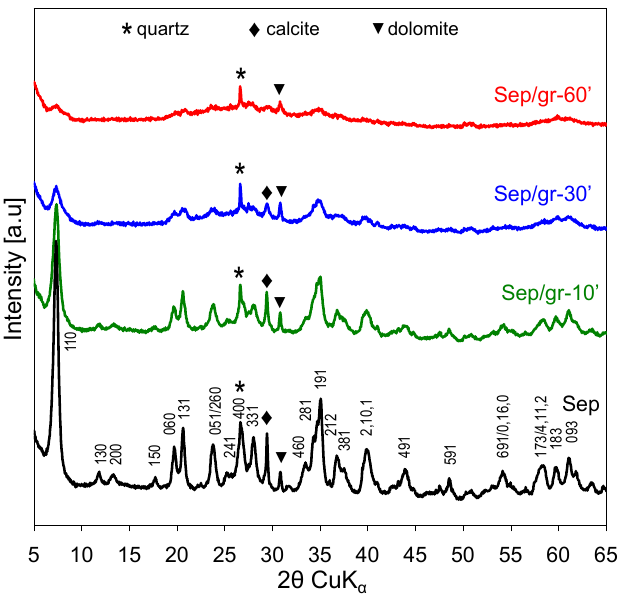
Figure 3. E ff ect of grinding on XRD patterns of Figure 3. Effect of grinding on XRD patterns of sepiolite.